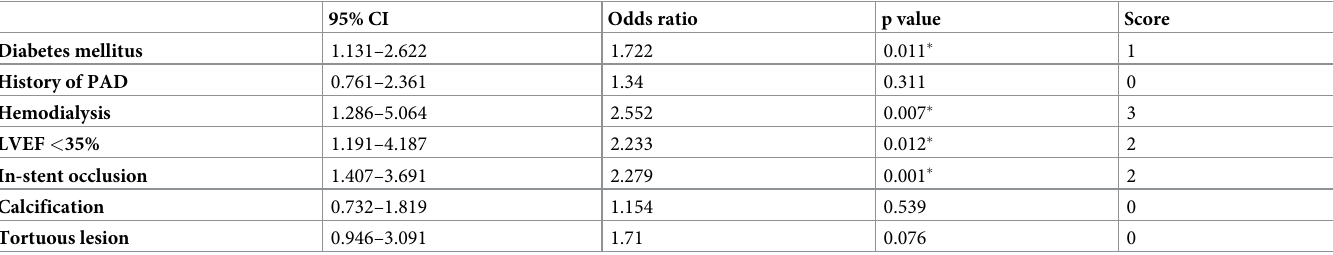
Table 3. Multivariate analysis for the incidences of MACCE and the scoring